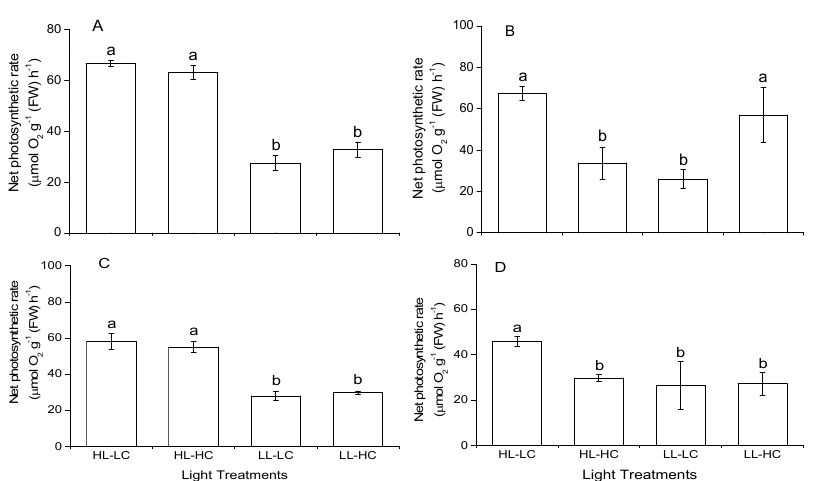
Figure 3. The instantaneous photosynthesis rate of Porphyra yezoensis under different CO 2 concen ‐ trations (400 μ atm, LC; 1000 μ atm, HC) and light treatments. ( A – D ) represent the instantaneous photosynthesis rate of algae under HL–LC, LL–LC, HL–HC, and LL–HC, cultured after transferring to different light intensities and CO 2 concentrations, respectively. Values show the mean ± SD. Different letters (a and b) represent significant differences ( p < 0.05) at different light treatments and CO 2 levels.